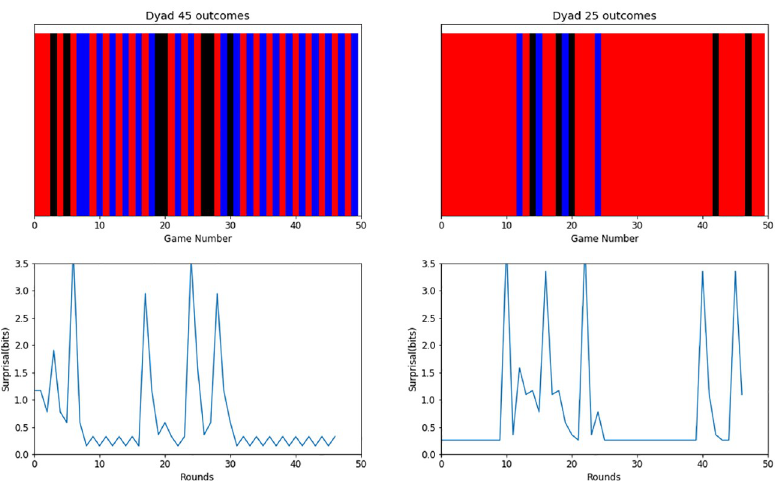
Fig 6. Dyad results. Top panel: Outcomes of two dyads of CRL agents (dyad 45 on the left, dyad 25 on the right) in the high dynamic condition, showing the formation of turn-taking (left) and pure dominance (right) equilibria. Each bar represents the outcome of a round of the game. A red bar means that player 1 got the high reward, and a blue bar means that player 2 got the high reward. Black bars represent ties. Bottom panel: Surprisal measure over rounds of play. When a convention is formed, the surprise drops down because the outcomes start to be